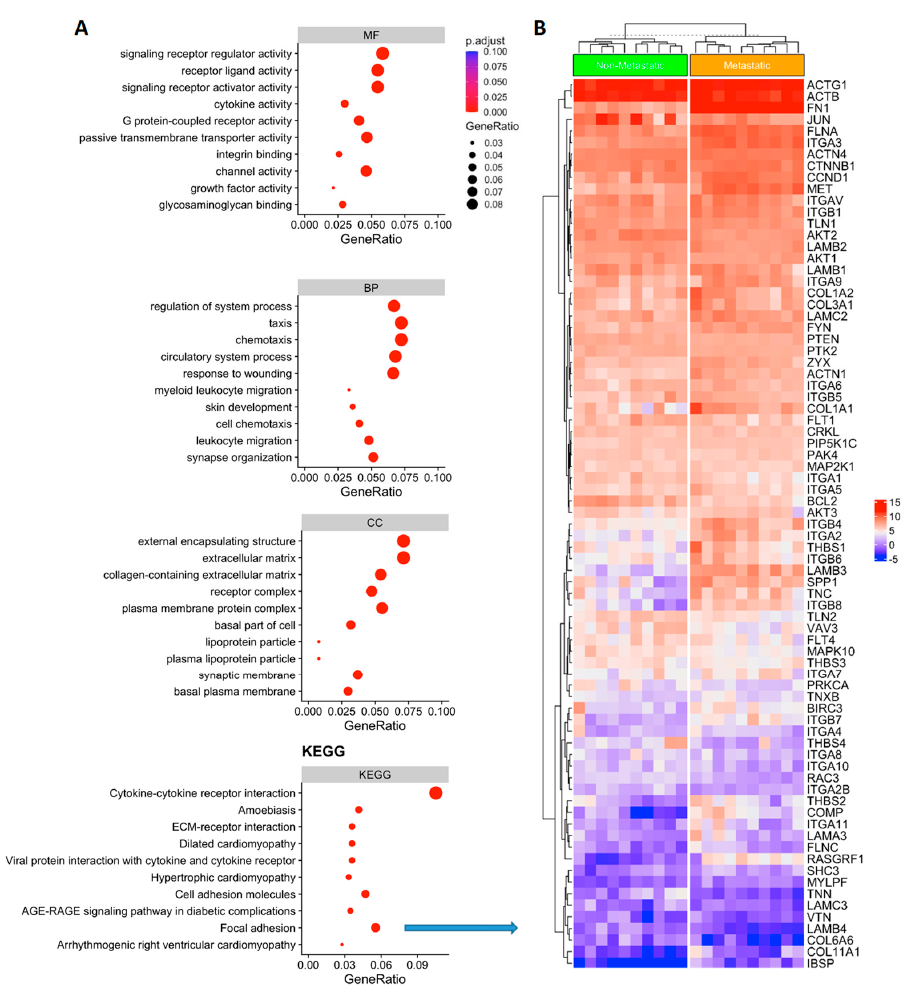
Figure 2. ( A ) Gene representation and gene set enrichment (GSEA) analysis of the differentially expressed genes. Gene Ontology (GO) enrichment analysis results showed the main differences regarding MF: molecular function; CC cellular component; and BP: biological process. KEGG pathways enrichment analysis (Kyoto Encyclopedia of Genes and Genomes) identified the focal adhesion gene network signaling with significant expression differences comparing metastatic vs. non metastatic thyroid cancer (KEEG; focal adhesion p ≤ 0.05). ( B ) Heatmap showing the focal adhesion gene expression in metastatic vs. non-metastatic PTC). Upregulated genes are shown in red and downregulated genes are shown in blue.